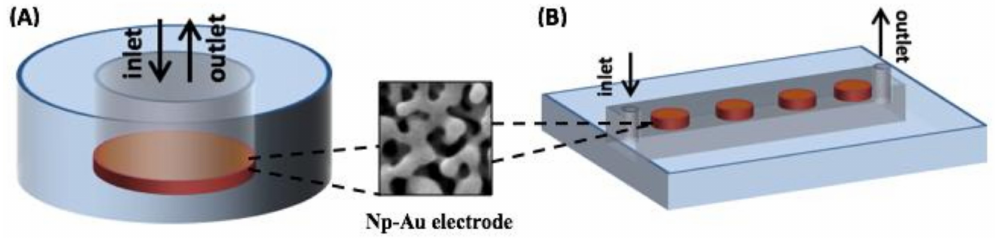
Figure A2. Schematic of ( A ) macro-scale electrochemical cell with np-Au electrode diameter of 4 mm and ( B ) microfluidic electrochemical cell with np-Au electrode diameter of 0.3